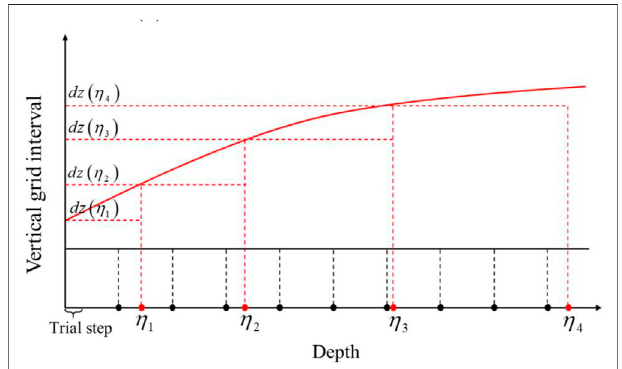
FIGURE 2 | Diagrammatic sketch of the adaptive sampling